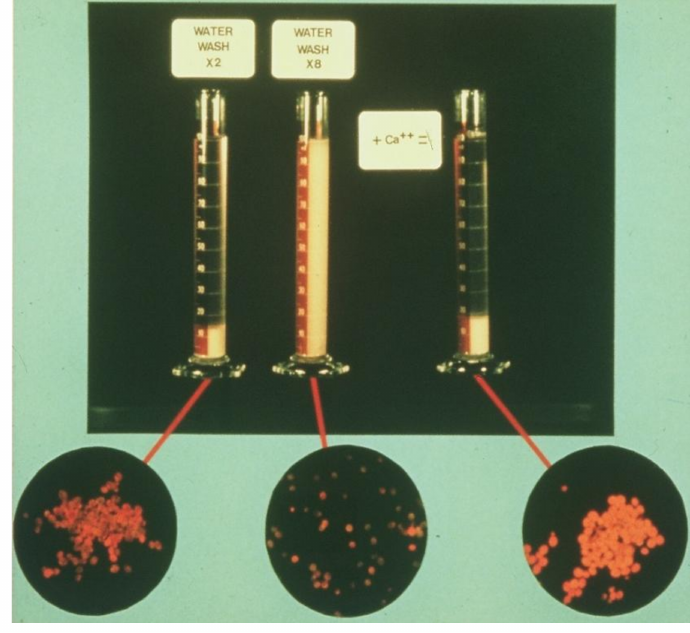
Figure 15. De-flocculation of yeast as a result of repeated water washing and re-flocculation following the addition of calcium ions